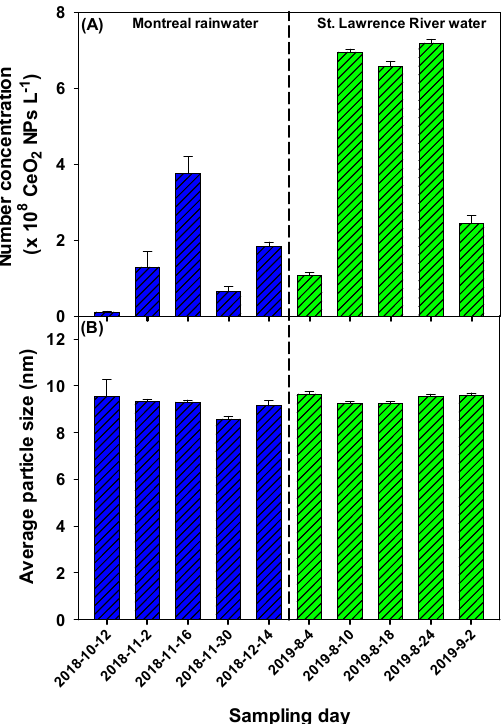
Figure 5. ( A ) Number concentrations and ( B ) mean particle sizes for CeO 2 NPs measured on different dates in rainwater (blue) and St. Lawrence River water (green). Error bars correspond to standard deviations obtained from triplicate analysis. Measurements were performed using wet-SF-ICP-MS and a dwell time of 50 µs.